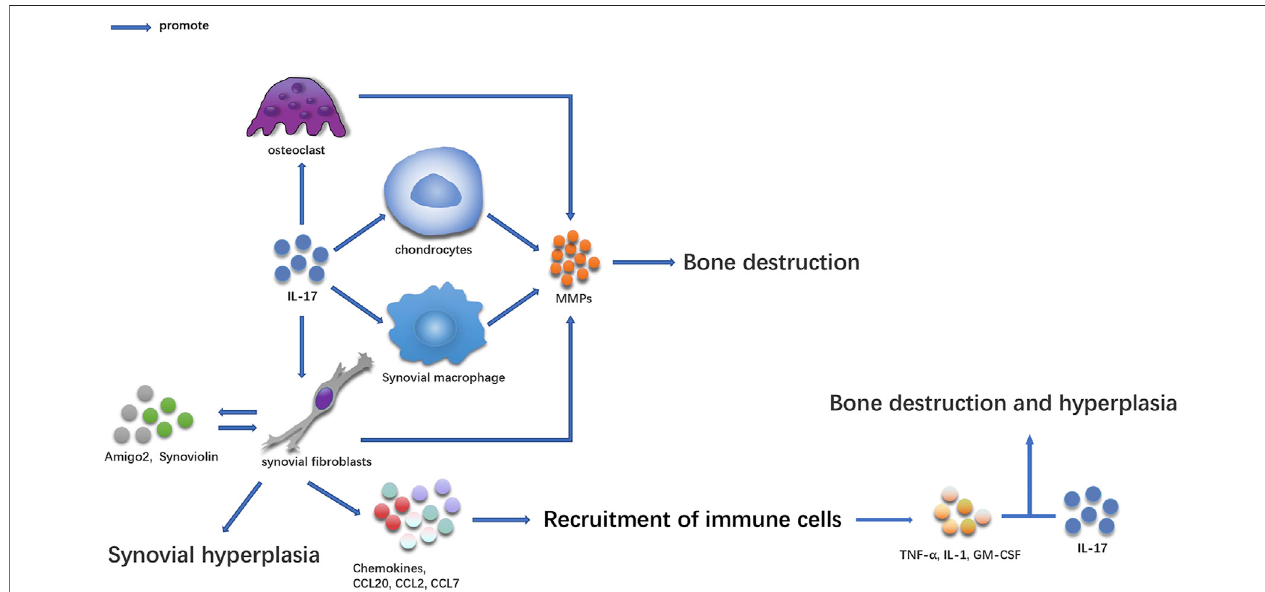
FIGURE 1 | The effect of IL-17 on bone in RA